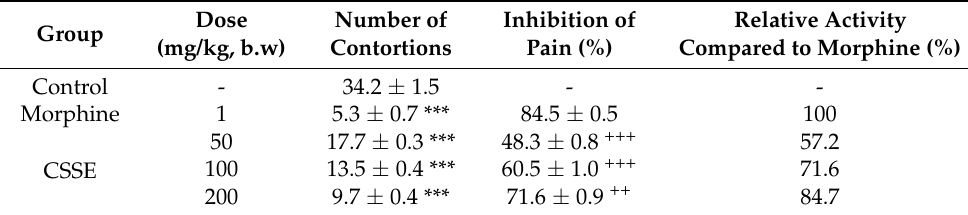
Table 4. Effect of CSSE on abdominal contractions induced by intraperitoneal injection of acetic acid in mice. Dose Number of Inhibition of Relative Activity Group (mg/kg, b.w) Contortions Pain (%) Compared to Morphine (%)